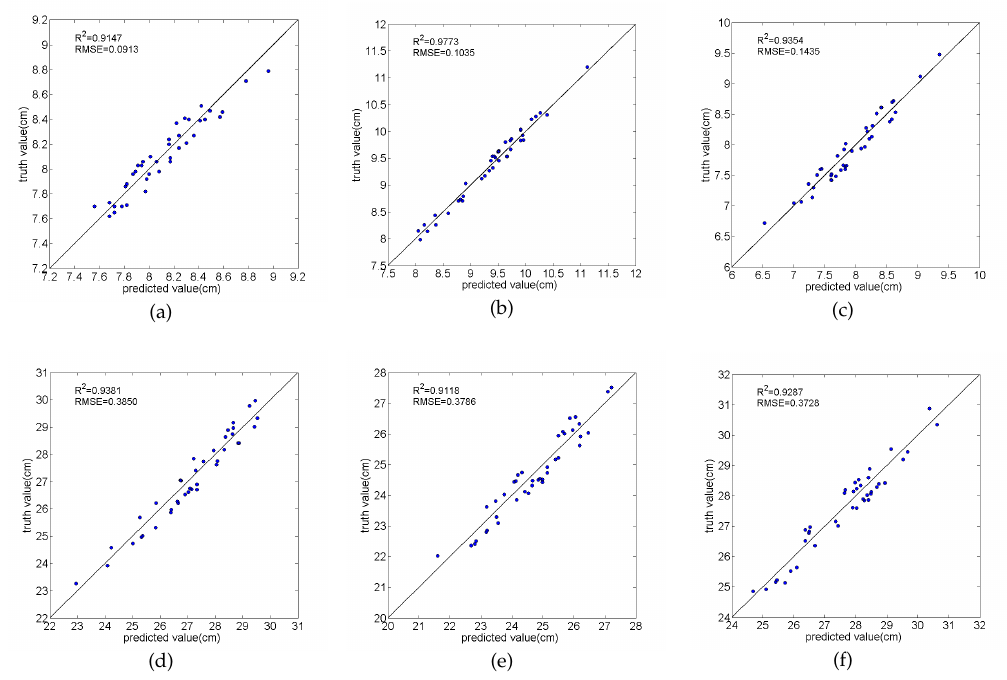
Figure 9. The phenotypes include length, height, width, x -axis perimeter, y -axis perimeter, and z -axis perimeter, recording as ( a – f ). ( a ) Comparison of length values. ( b ) Comparison of height values. ( c ) Comparison of width values. ( d ) Comparison of x -axis perimeter. ( e ) Comparison of y -axis perimeter. ( f ) Comparison of z -axis perimeter.